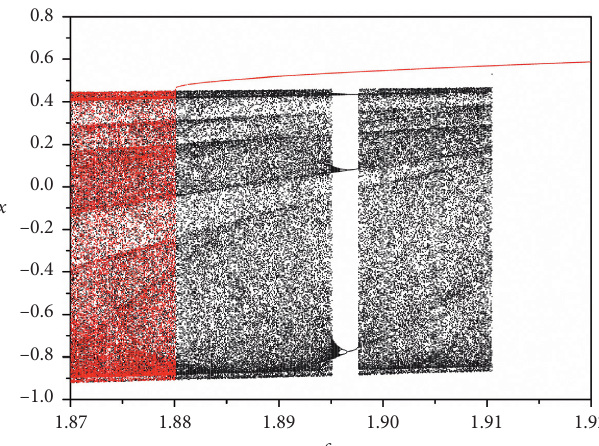
Figure 5: Continuation bifurcation diagrams of system (2) for increasing (black) and decreasing (red) values of c in the range of 1.87 ≤ c ≤ 1.92, for a � 1.4, b � 0.3, and d � 0.9.